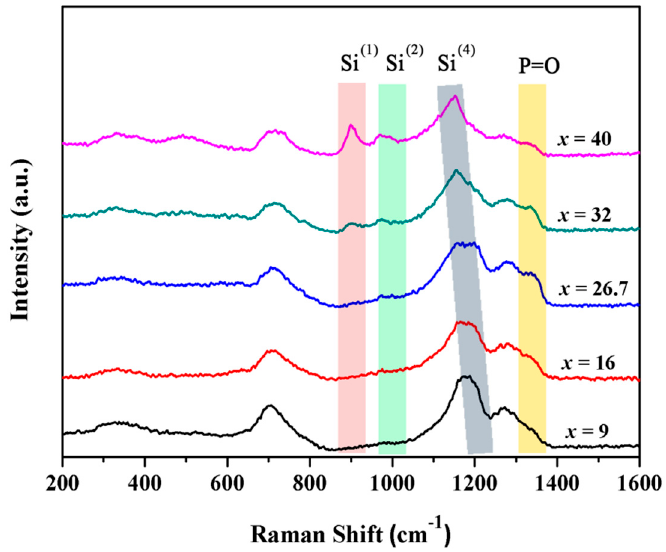
Figure 4. Micro-Raman spectra of 20BaO-(80- x )P 2 O 5 - x SiO 2 -1Yb 2 O 3 ( x = 9, 16, 26.7, 32, and 40 mol %, respectively) glasses.